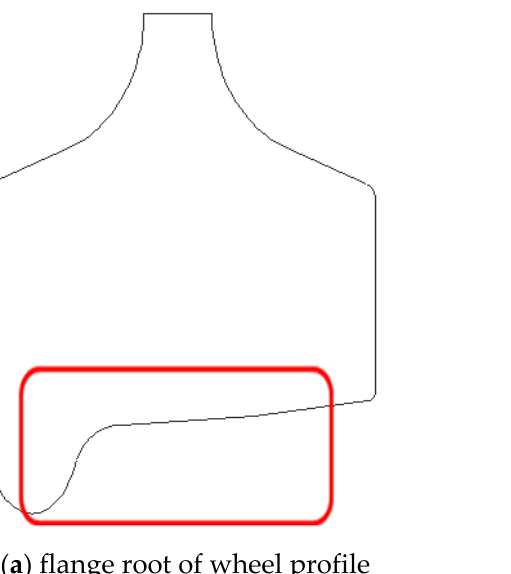
Figure 4. Design variables of wheel profile.